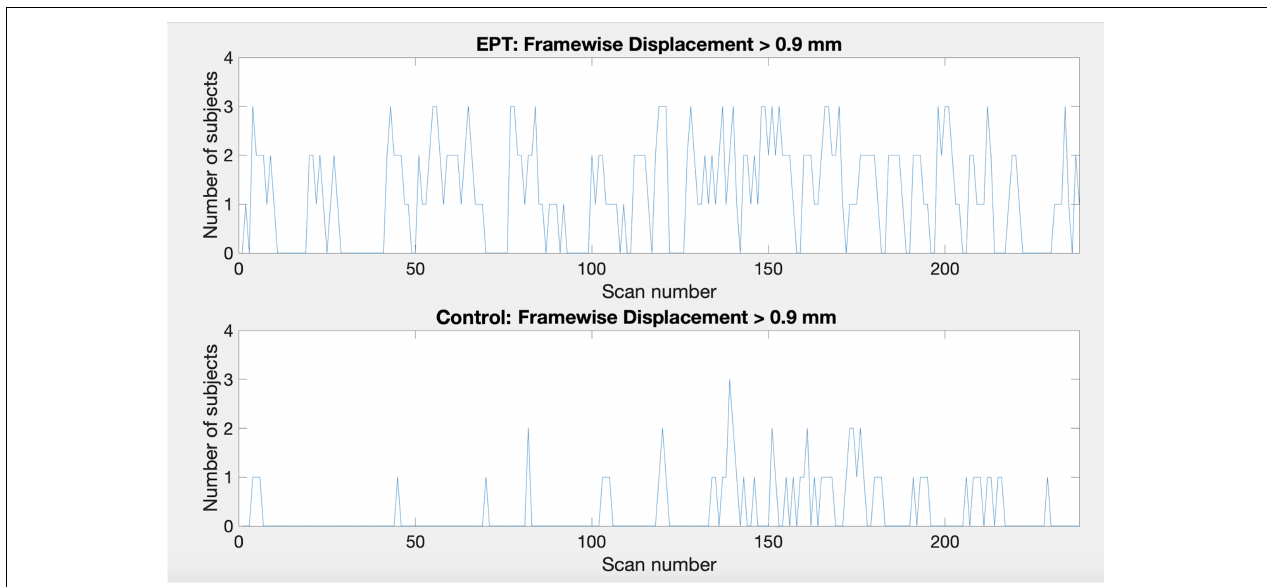
FIGURE 8 | Plots showing the number of subjects that pass the framewise displacement threshold of 0.9 mm for each scan. Top: EPT subjects, bottom: control